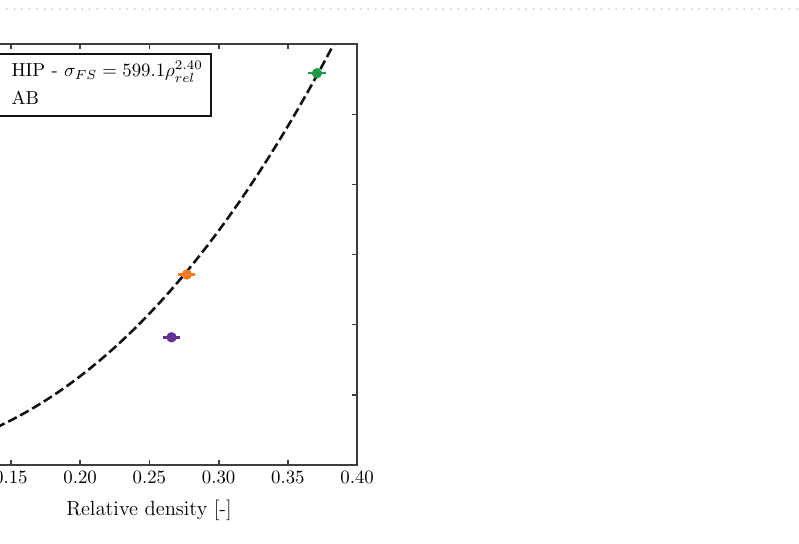
Figure 15. Failure surface after HIP for ( a ) 10% stiffness loss and ( b ) collapse of structure.